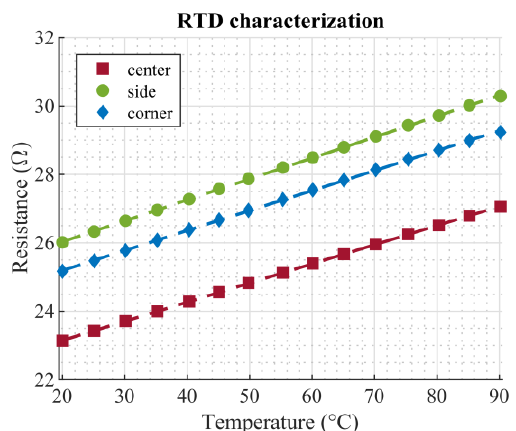
Table 1. Fitting parameters of calibration curves.